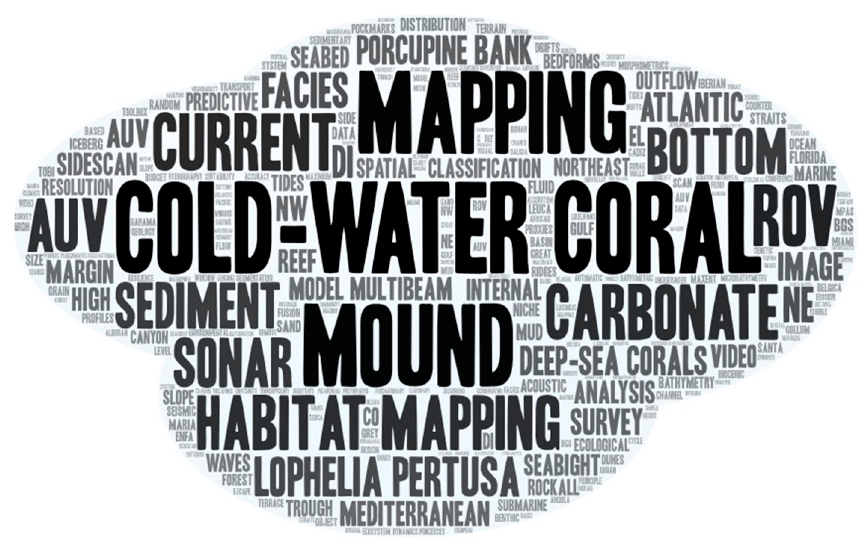
Figure 1. Word cloud of the most frequent significant terms in the reviewed articles.